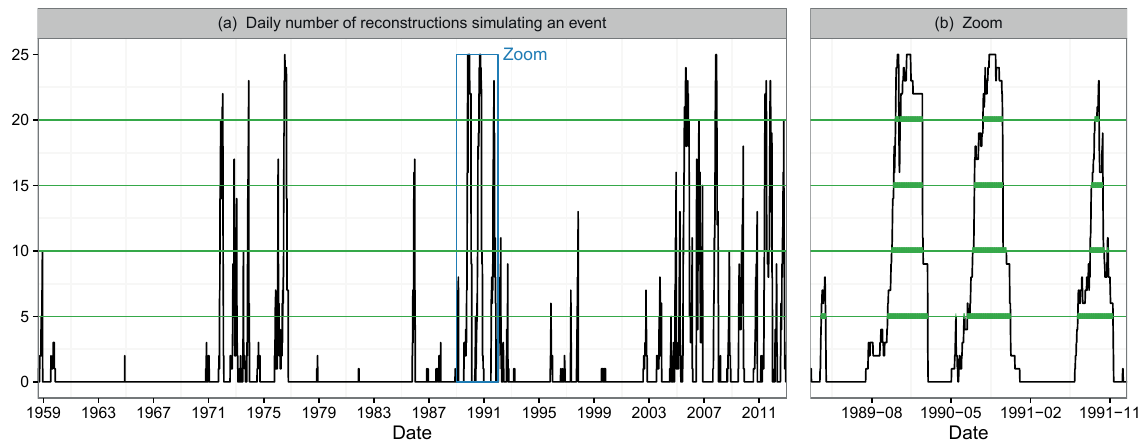
Figure 6. Deriving average events for Station 1 in HER 11. (a) Daily number of members simulating an event between 1 August 1958 and 29 December 2012. (b) Zoom on the 1989–1991 period. Examples are taken with four possible minima, set at 5, 10, 15, or 20 members.